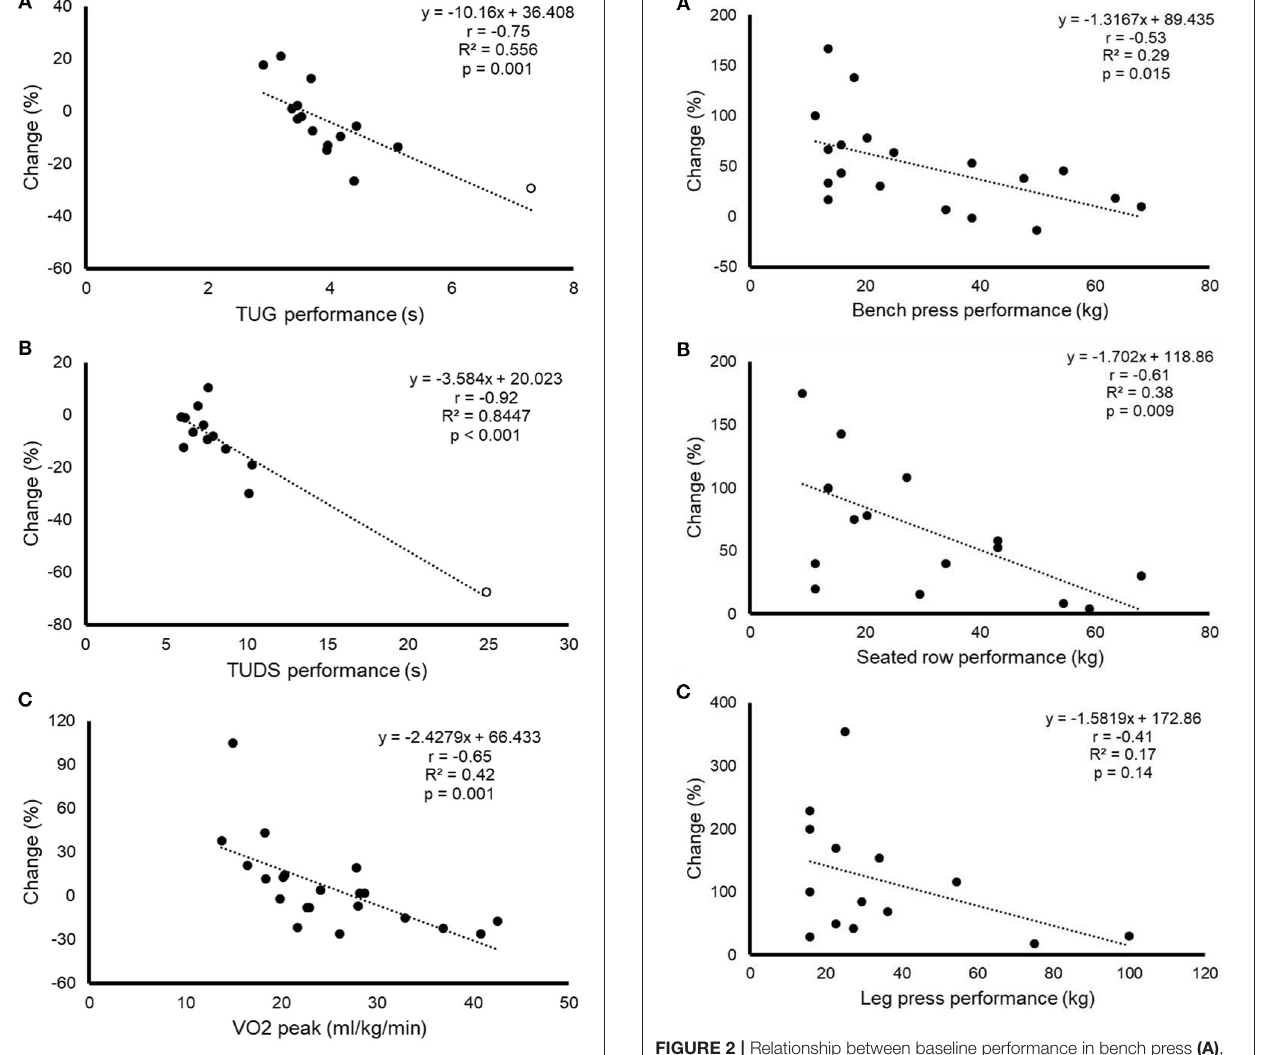
FIGURE 1 | Relationship between baseline performance in the timed up and go (TUG) test (A) , the timed up and down stair (TUDS) test (B) and cardiorespiratory fitness [CRF, expressed as peak oxygen uptake [VO 2peak ]), (C) ], on the one hand, and the relative change in performance for each test after the exercise training intervention, on the other. When outliers [white dots in (A,B) ] were removed from the analysis, the relationship was still significant for both TUG ( r = − 0.74, p = 0.002) and TUDS ( r = − 0.68, p = 0.01).